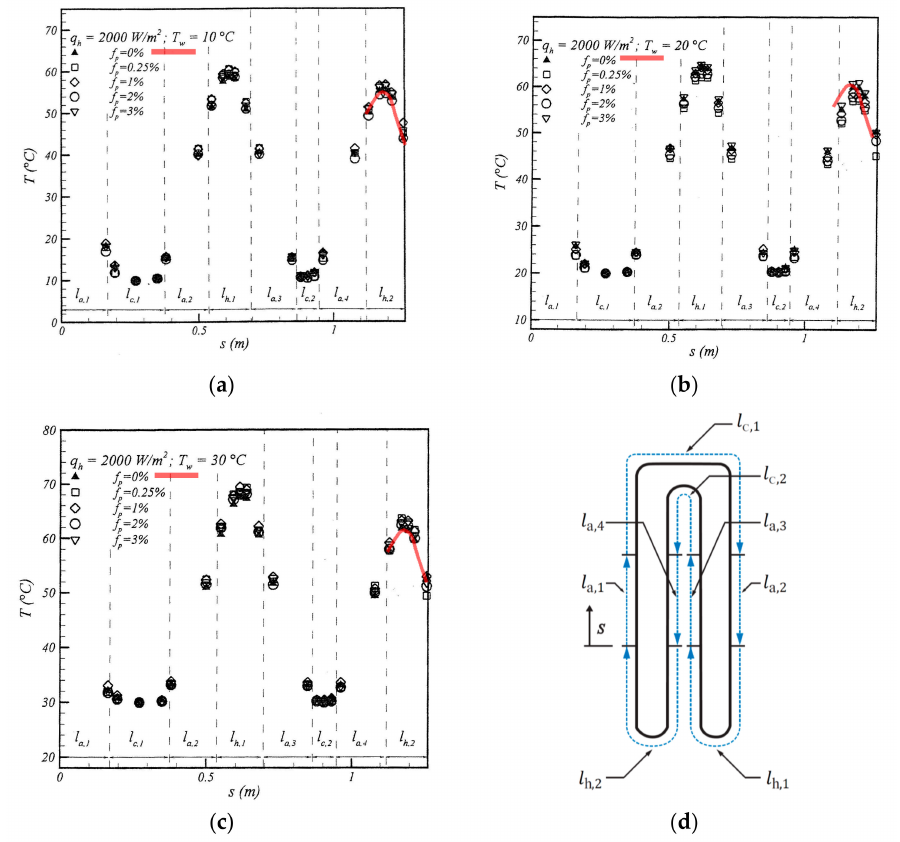
Figure 9. Steady-state temperature distributions of the fluid under different f p s ( q h = 2000 W/m 2 ): ( a ) T w = 10 ◦ C; ( b ) T w = 20 ◦ C; ( c ) T w = 30 ◦ C; ( d ) The experimental